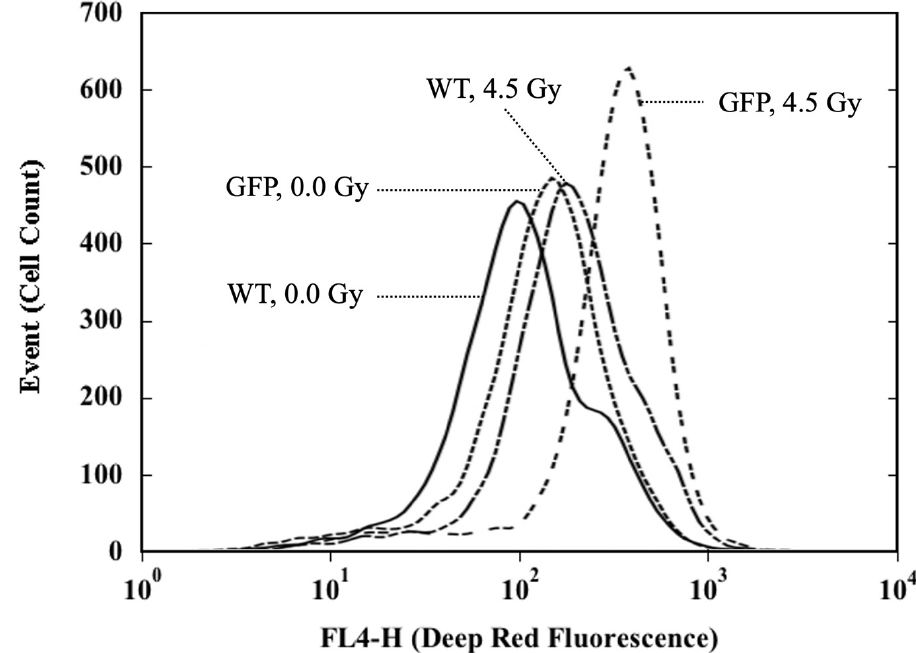
Figure 3. Modal representation of the number of cells as a function of the fluorescence emission intensity of ROS detector Deep Red. Nucleated bone marrow cells collected from animals at eight postnatal weeks were ex vivo irradiated (4.5 Gy) or sham-irradiated (0.0 Gy) with X-rays, and induction of ROS was measured flow cytometrically using channel FL-4. The fluorescence signal was monitored at an excitation wavelength of 650 nm and an emission wavelength of 675 nm for Deep Red detection. “0.0 Gy” represents cells receiving sham-irradiation. “4.5 Gy” represents cells receiving 4.5 Gy.